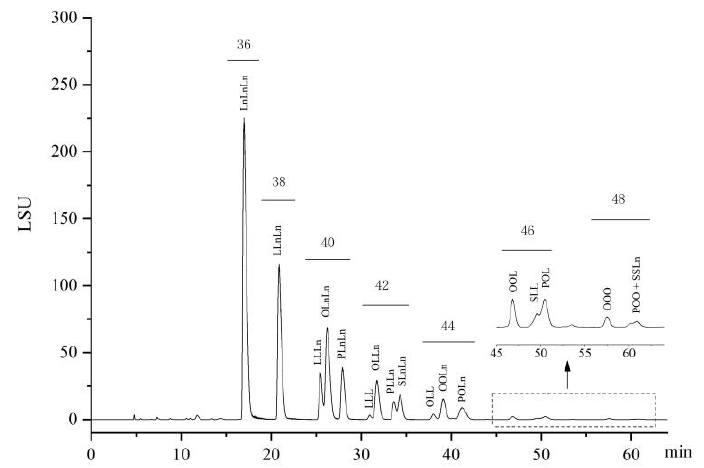
Figure 1. HPLC chromatogram of the triacylglycerol composition of raw flaxseed oil. Notes: LSU is the unit of signal response of the device when using an evaporative light scattering detector; the numbers above peaks represent the equivalent carbon number (ECN).